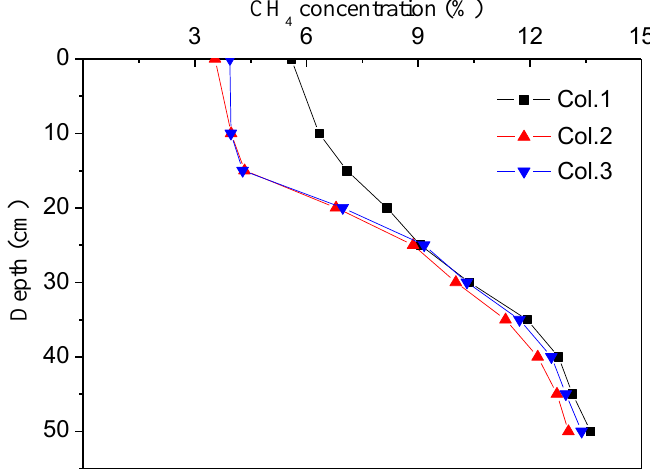
Figure 5. CH 4 concentration profile along the column depth.